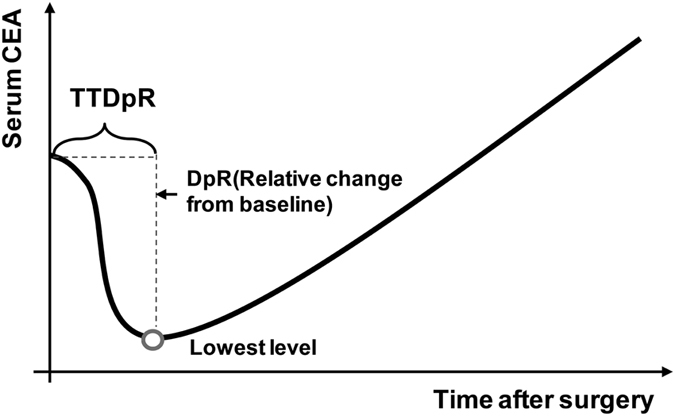
The curve of CEA change in most patients treated with adjuvant chemotherapy.